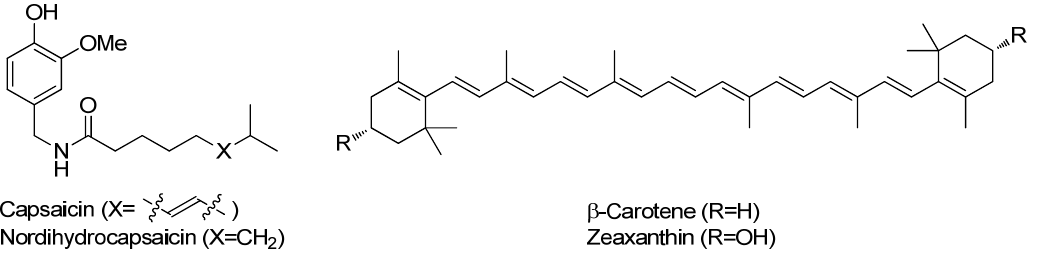
Figure 1. Capsaicinoids and